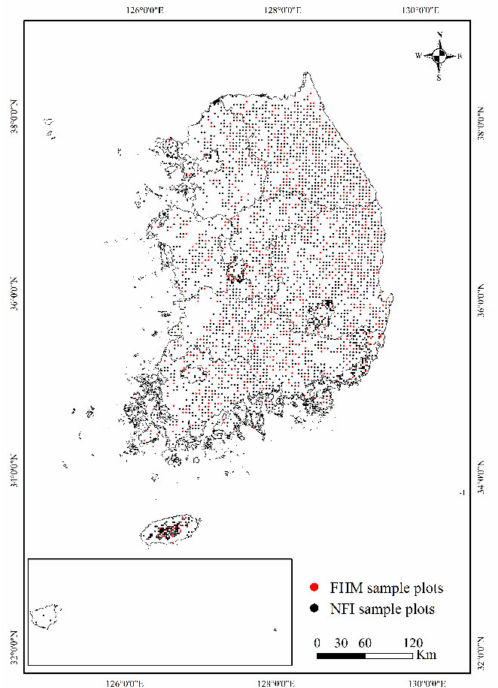
Figure 1. Distribution of National Forest Inventory (NFI) and Forest Health Monitoring (FHM) sample plots in South Korea